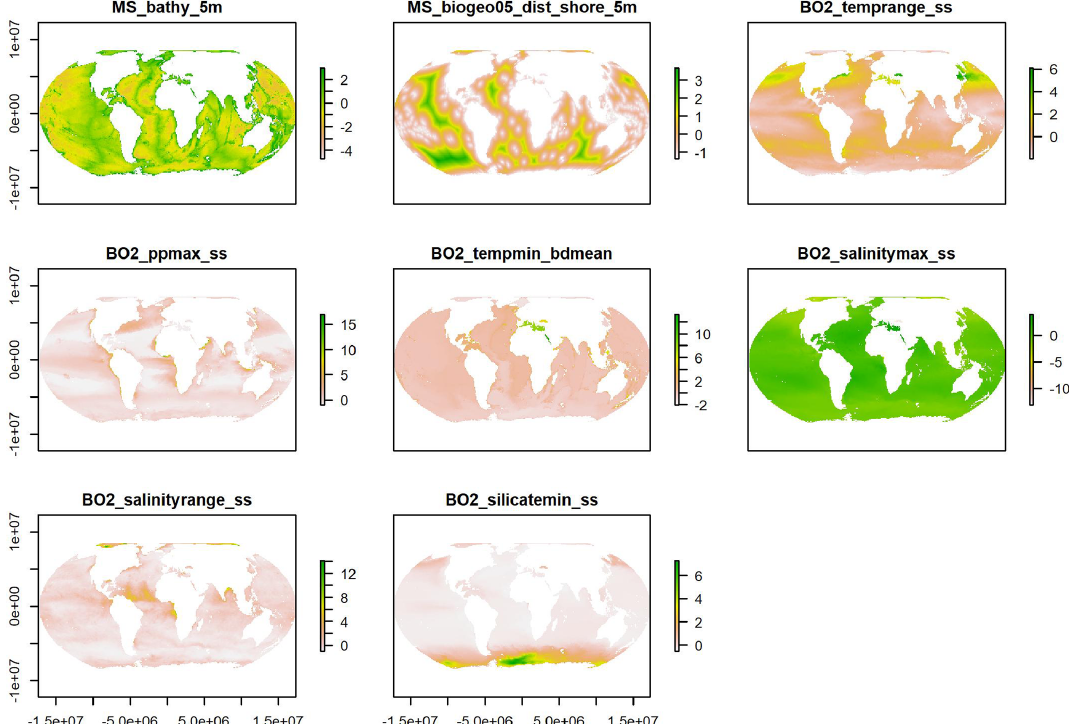
Figure A1. Plots of the selected scaled predictor